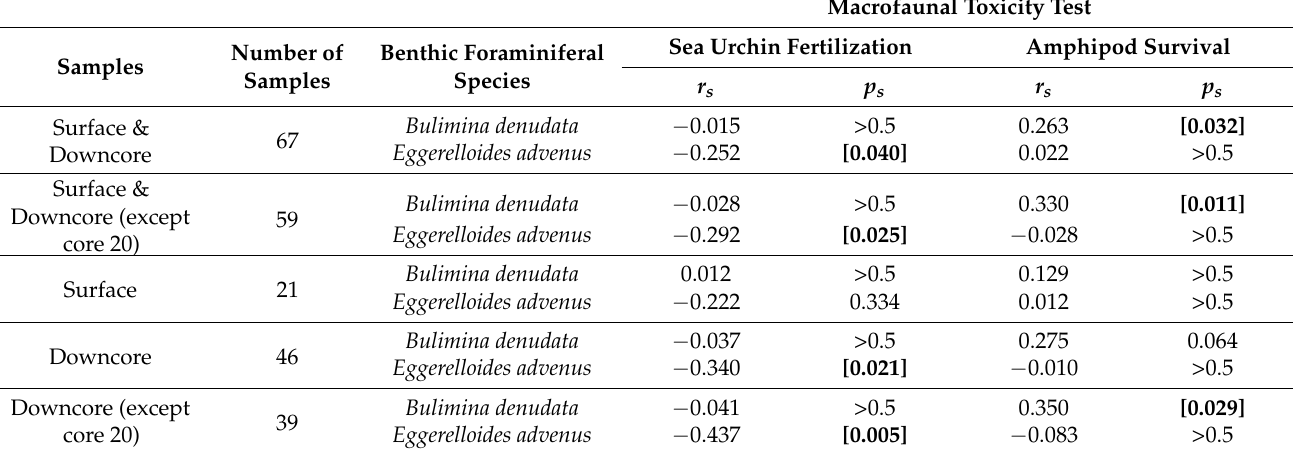
Table 3. Spearman rank correlations for species abundances of Bulimina denudata and Eggerelloides advenus with macrofaunal toxicity results (sea urchin fertilization and amphipod survival). Values square root transformed before correlation. Significant correlations ( p < 0.05) are in square brackets and